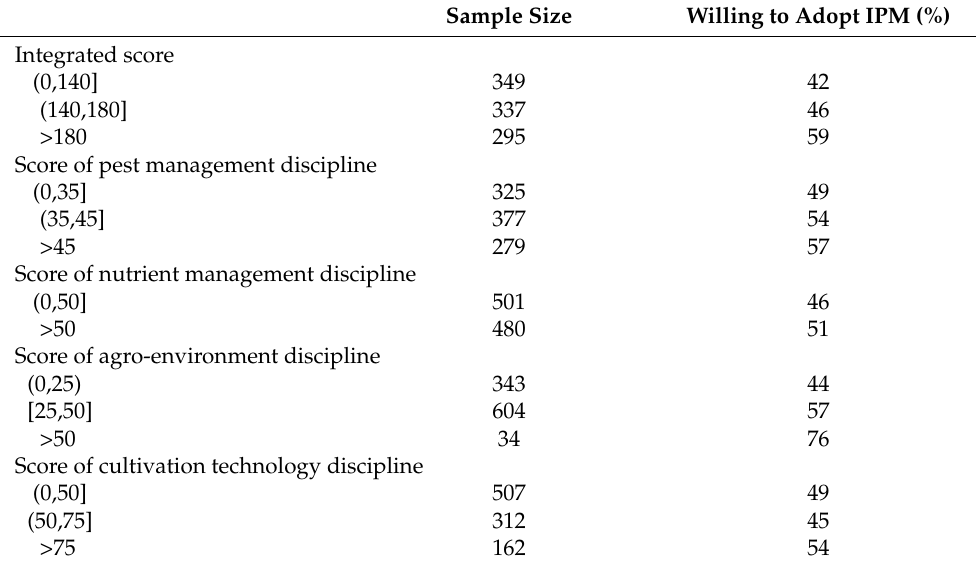
Table 4. The relationship between scores and farmers’ willingness to adopt IPM technology. Sample Size Willing to Adopt IPM